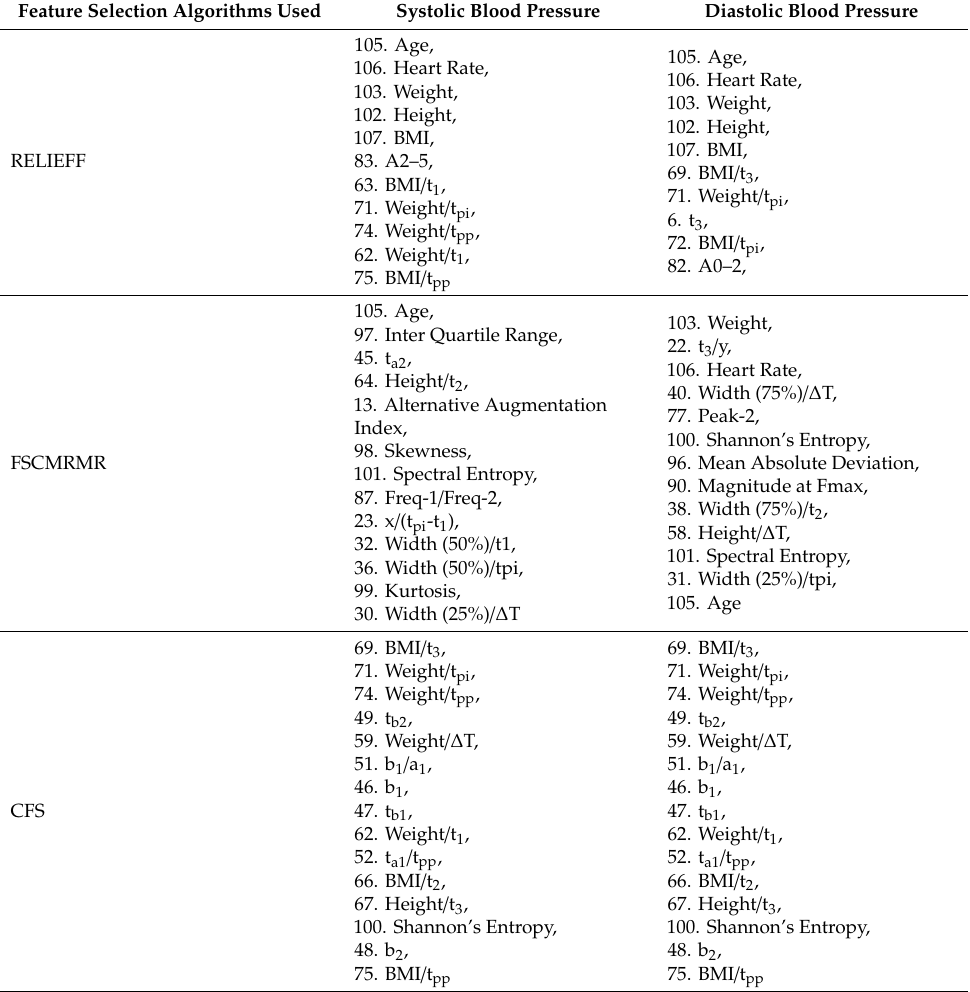
Table 9. Features chosen by the feature selection